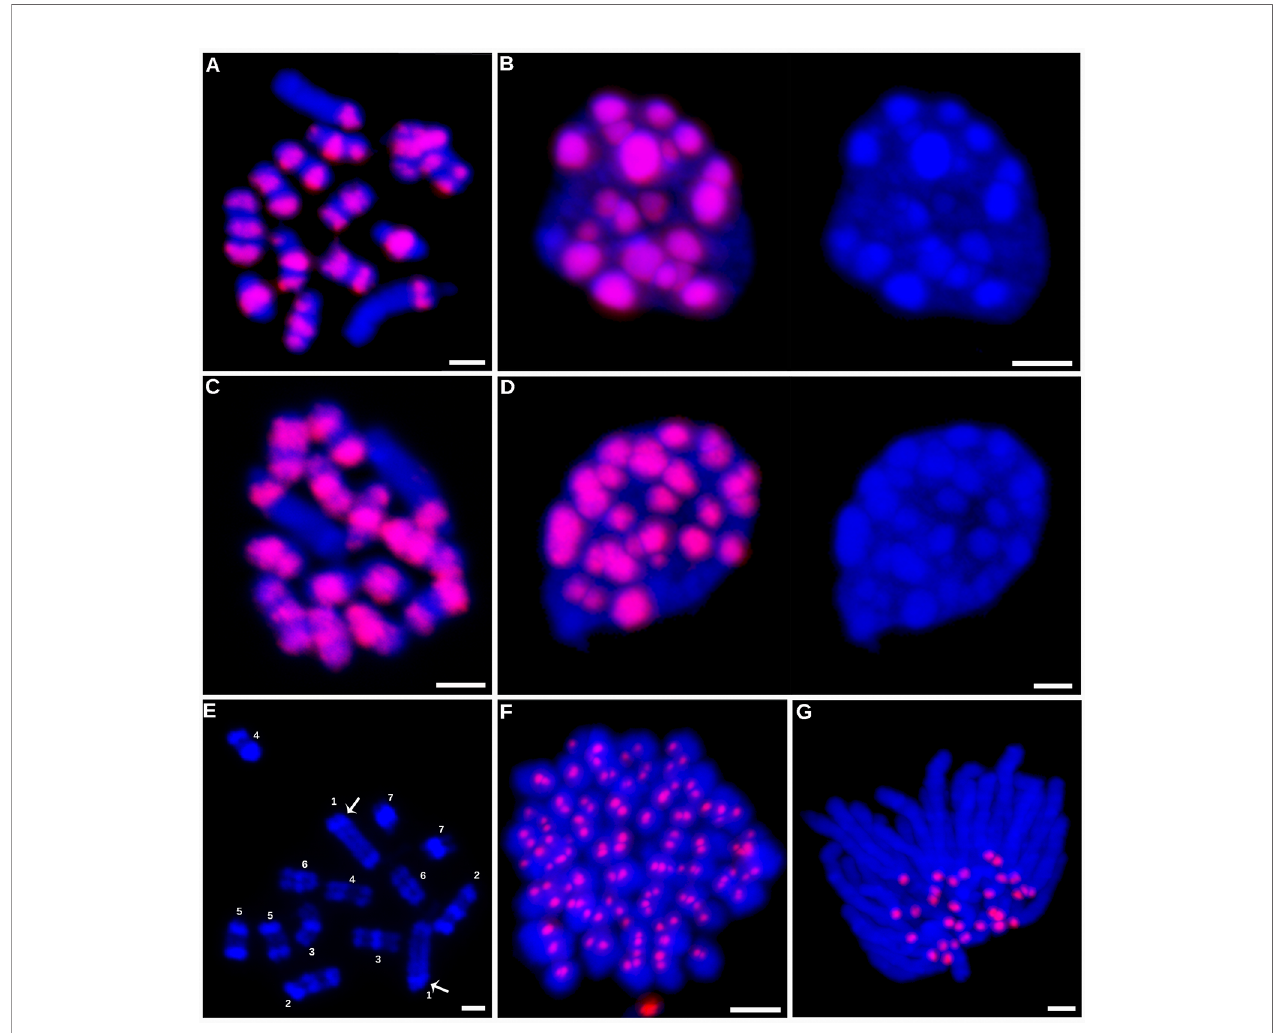
FIGURE 2 | Immunodetection of CENH3 proteins. Immunodetection of CENH3 proteins in C. europaea (A – D). Detection of the CENH3 CEURO-1a/b variant on metaphase chromosomes (A) and interphase nucleus (B) . Detection of the CENH3 CEURO-2 variant on metaphase chromosomes (C) and interphase nucleus (D) . Nuclei in the panels (B and D) are shown with and without the CENH3 signals to demonstrate correlation between the distribution of CENH3 and DAPI-positive heterochromatin domains. (E) Distribution of DAPI-positive heterochromatin domains on C. europaea metaphase chromosomes, prepared from 3:1 fi xed meristems to achieve better contrast between heterochromatic and euchromatic regions. Distribution of the heterochromatin domains allowed to distinguish all seven chromosome pairs in this species. Arrows mark the heterochromatin band on chromosome 1 that lacked CENH3 signal. (F) Detection of CENH3 CCAMP-a/b on metaphase chromosomes of C. campestris . (G) Detection of CENH3 CJAPO on anaphase chromosomes of C. japonica. CENH3 signals and DAPI-stained chromosomes are shown in red and blue, respectively. Scale bars = 2